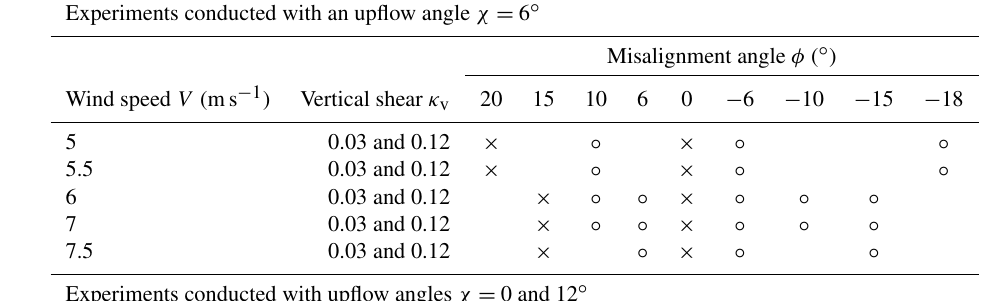
Table 1. Test matrix for the wind tunnel experiments. Symbol “ × ” marks the identification set; “ ◦ ” marks the validation set. Experiments conducted with an upflow angle χ = 6 ◦